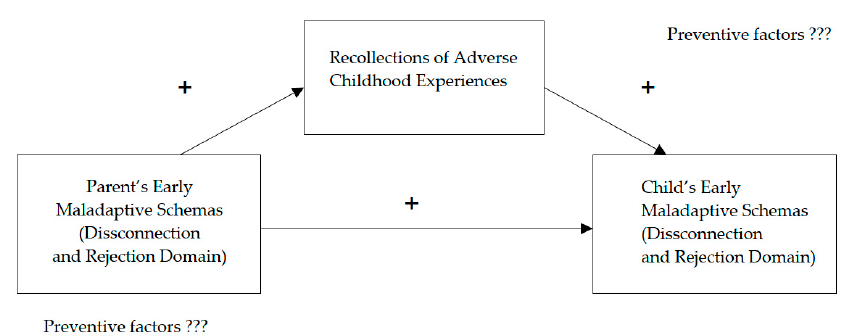
Figure 2. The proposed model of the mediation of recollections of adverse childhood experiences on the relationship between parent’s disconnection and rejection schemas and the child’s disconnection and rejection schemas.